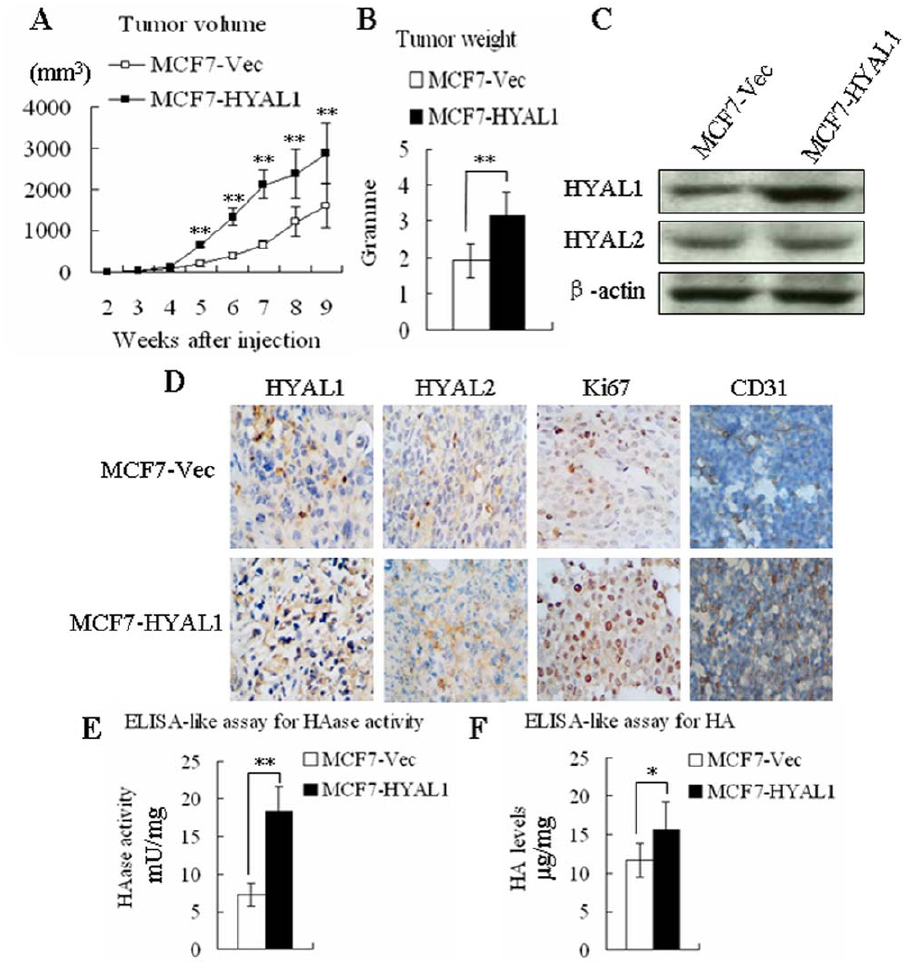
Figure 7. Upregulation of HYAL1 increased tumor growth, angiogenesis, HAase activity and HA expression of MCF7 cells in vivo. Representative mouse bearing tumors, the average tumor volume (A) from 5 th weeks and tumor weight (B) in MCF7-HYAL1 group were increased significantly than in MCF7-Vec group ( p , 0.01). Western blot (C) and immunohistochemistry (D) analysis showed that the expression of HYAL1 protein was enhanced in the MCF7-HYAL1 group obviously, but HYAL2 levels were not altered. Compared with MCF7-Vec, expression of ki67 and CD31 were increased in MCF7-HYAL1 (D). ELISA-like assay measured HAase activity (E) and HA levels (F) present in the tissue extracts, the HAase activity and HA levels in MCF7-HYAL1 were higher than MCF7-Vec ( p , 0.01, p , 0.05,